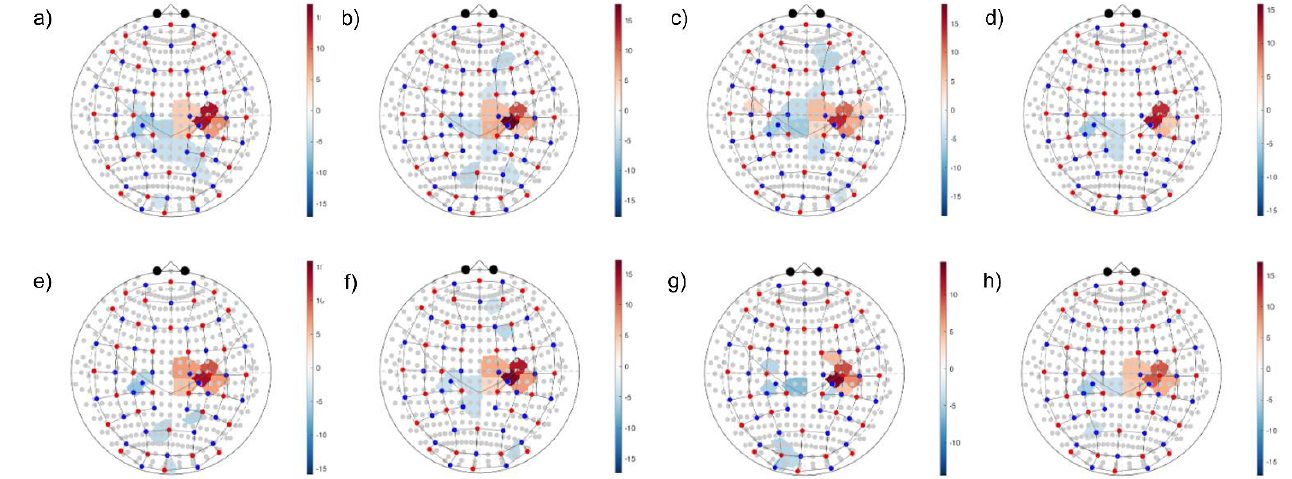
Figure 10. Second-level activation vs. resting condition statistical maps related to the left-hand motor grasp of ∆ [ HbO 2 ] . Colorbars indicate significant t-values corrected for multiple comparisons ( p FDR < 0.05). Positive t-values indicate locations where the mean of ∆ [ HbO 2 ] activation was significantly higher than that in the resting condition, and conversely for negative values. ( a ) SC-MARA-spline, ( b ) MC-MARA-spline, ( c ) SC-MARA-tPCA, ( d ) MC-MARA-tPCA, ( e ) HybridMARA-spline SG, ( f ) HybridMARA-tPCA SG, ( g ) TDDR, and ( h ) Wavelet method.